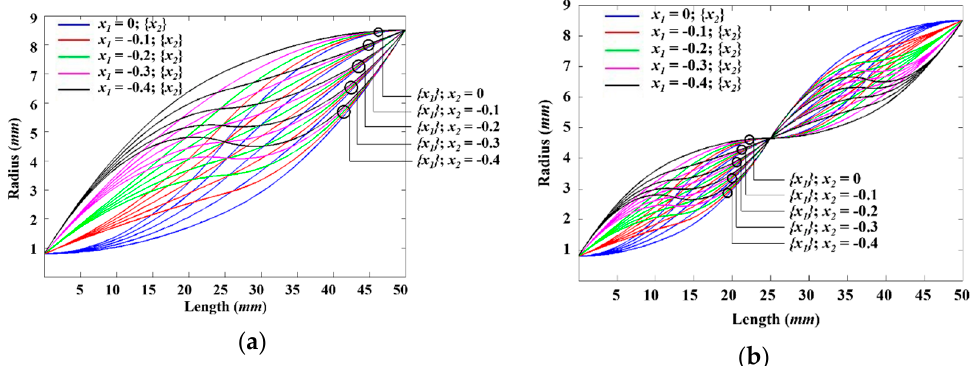
Figure 4. Different profiling options for ( x 1 , y 1 ) and ( x 2 , y 2 ) as ({ x 1 }, 1) and ({ x 2 }, 1). ( a ) Profile possibilities with 2 node points; ( b ) mirror image profile possibilities with 3 node points.